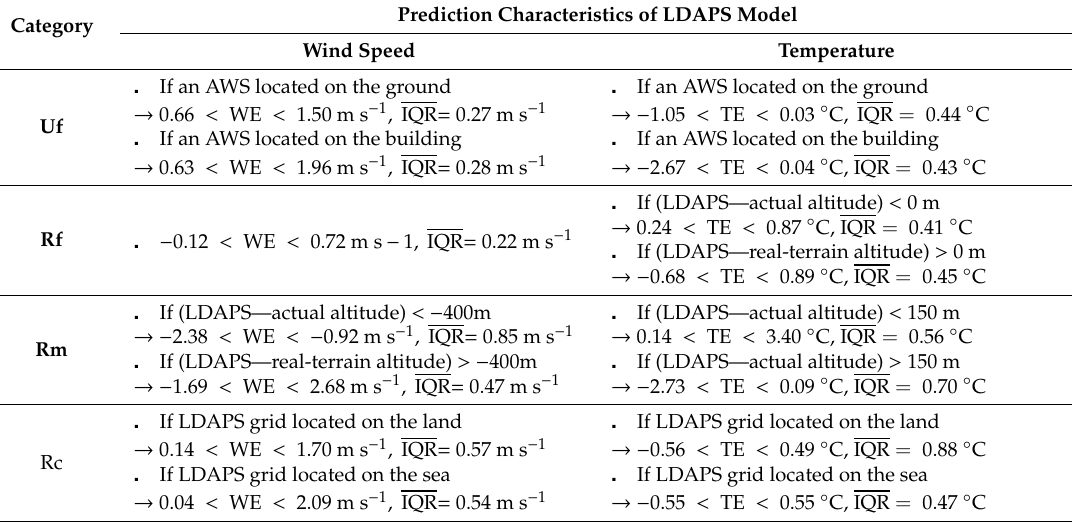
Table 2. Summary of the LDAPS characteristics for the four categories (Uf, Rf, Rm, and Rc).